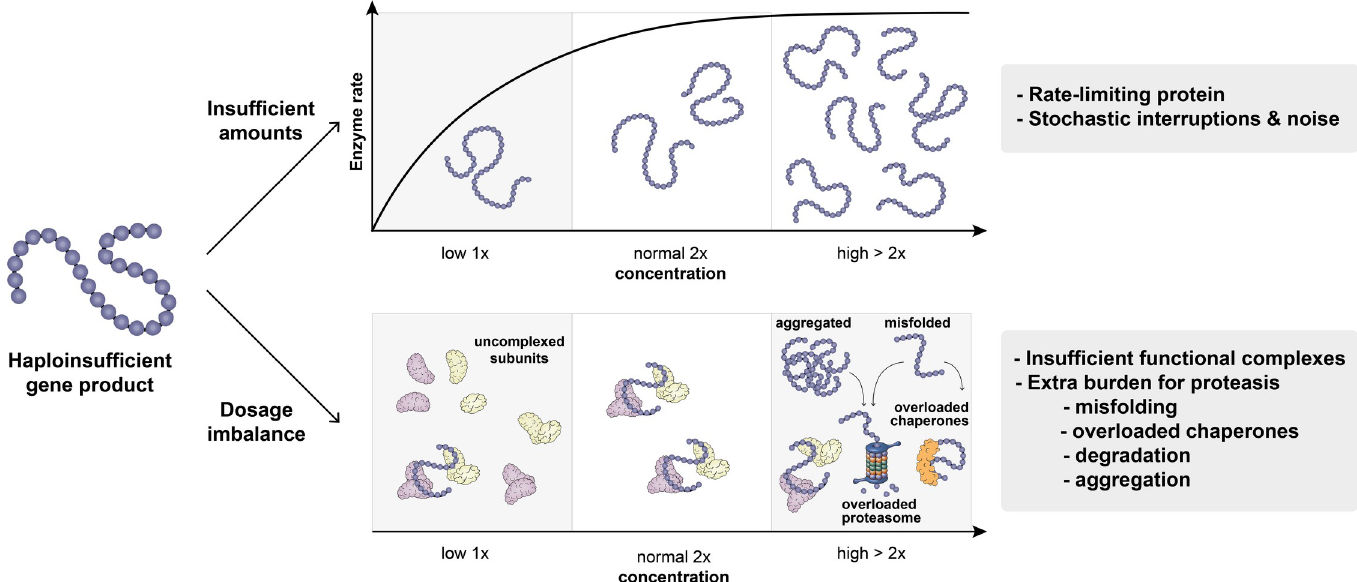
Fig 3. Molecular consequences upon gene dosage alterations. If gene dosage alterations reduce gene quantity, insufficient amounts of a protein (blue chain) can be produced (top). If the affected protein is rate limiting, for example, an enzyme, this can lead to fitness defects. Increases and reductions in gene quantity can also result in disrupted stoichiometry (bottom), if the affected protein (blue chain) interacts with other cellular macromolecules (illustrated as a complex consisting of a dimeric subunit A (purple), a dimeric subunit C (yellow) and the affected protein functioning as a bridge subunit B (blue)). This can lead to (a) change in the amount of functional complexes; (b) aggregation of uncomplexed subunits; and (c) overload of the chaperones and proteostasis network. Copy number increases can also lead to the aggregation of the protein products simply by reaching a critical, abnormally high concentration, promoting pathological transitions due to the protein’s physical